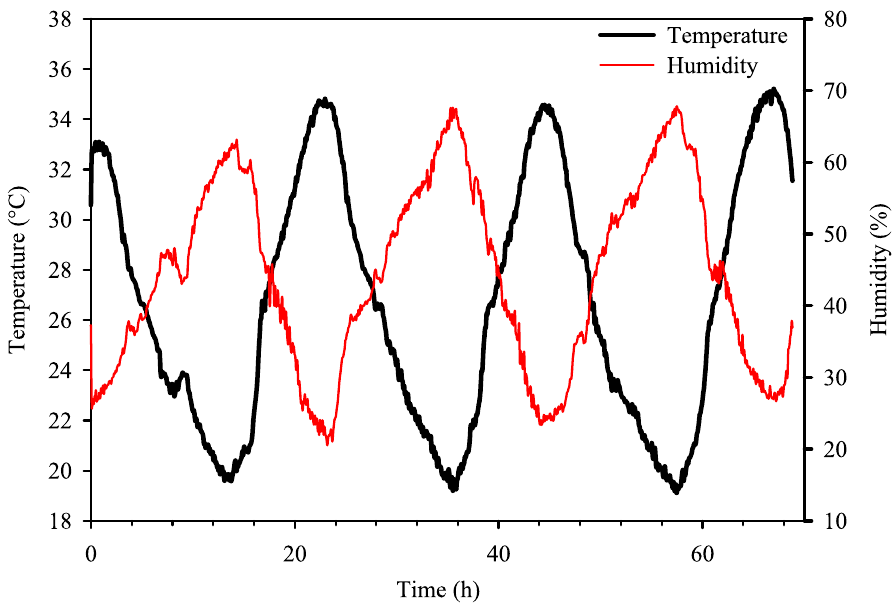
Figure 13. Values of the temperature and humidity measured by the node during the period 28 August 2015–31 August 2015.